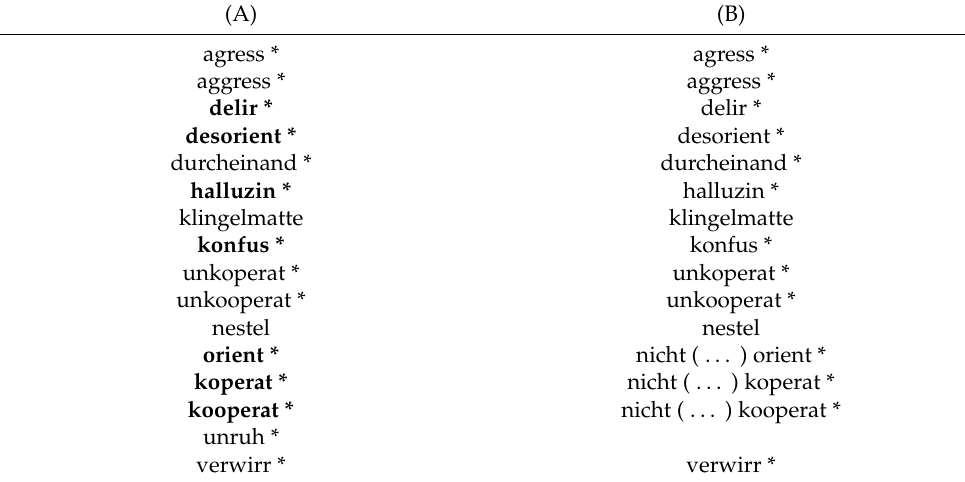
Table 1. Lists of delirium-predictive key words.